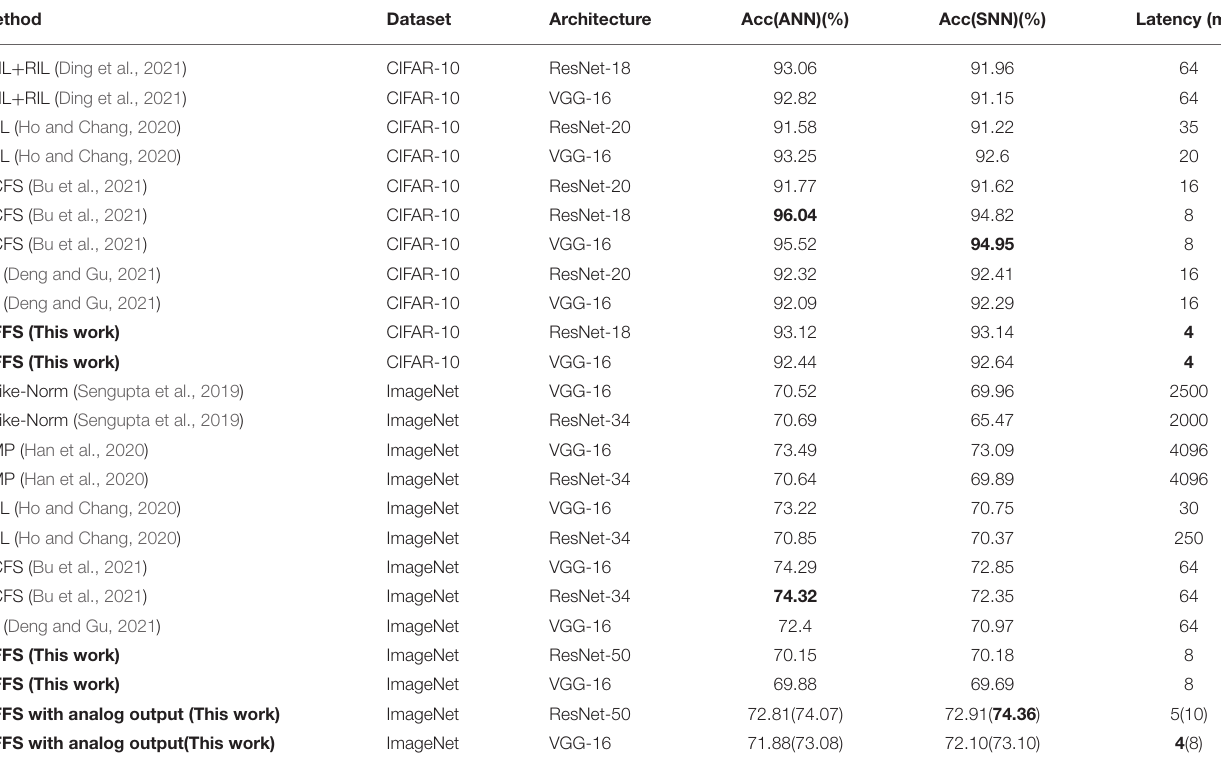
TABLE 3 | Benchmarking SNNs built by ANN-to-SNN conversion on CIFAR-10 and on